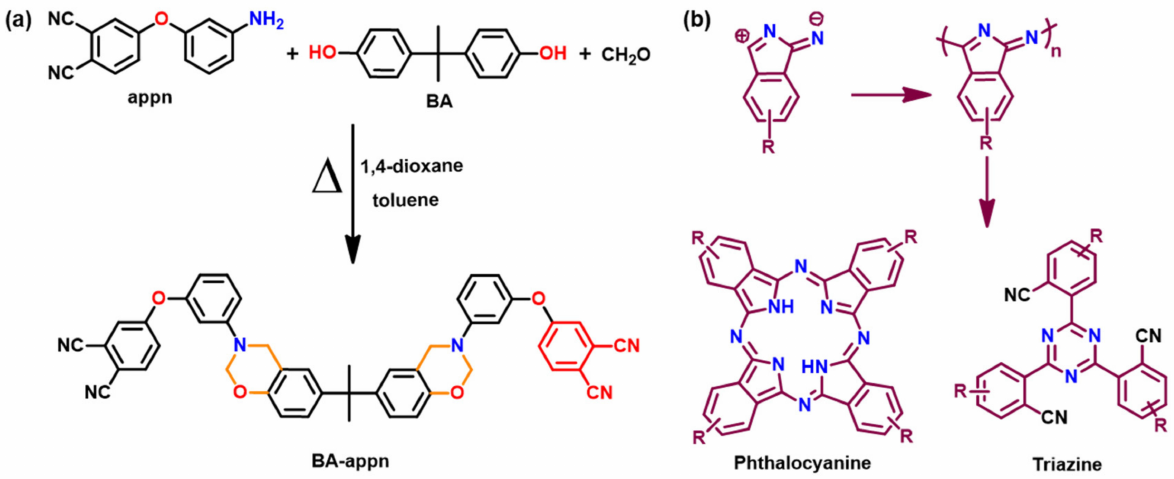
Figure 13. ( a ) Synthesis of phthalonitrile containing benzoxazine monomer [171] and ( b ) proposed nitrile groups based cyclic structures formed during polymerization